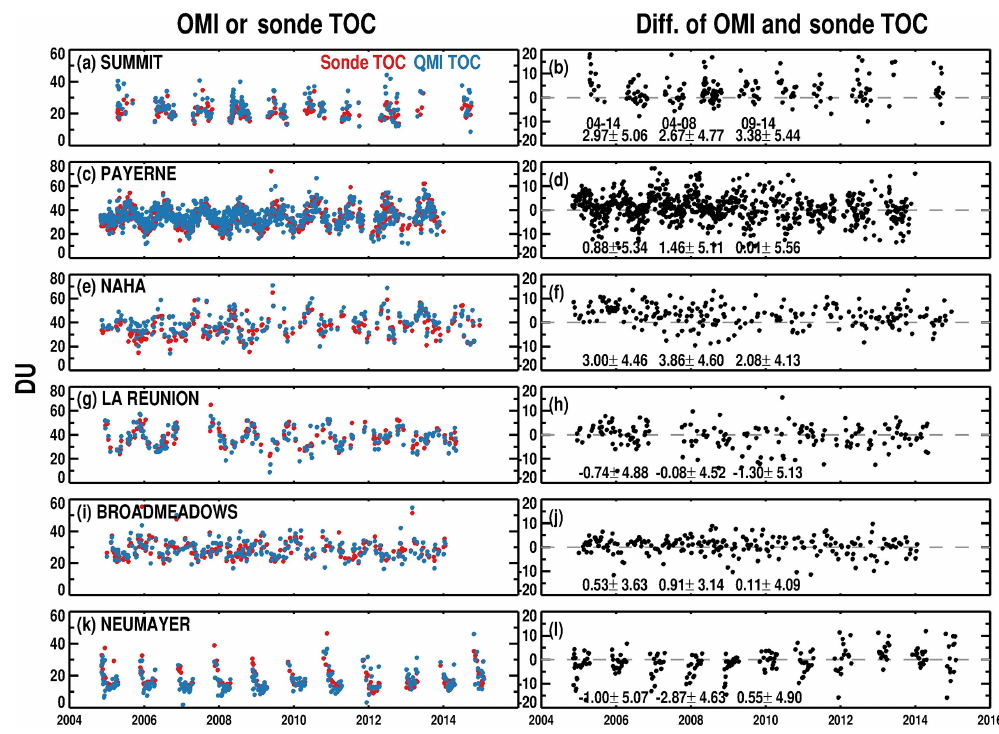
Figure 10. (a, c, e, g, i, k) Time series of OMI tropospheric ozone columns (TOCs) as green dots and ozonesonde TOCs (with OMI AKs applied) in Summit (38.48 ◦ W, 72.57 ◦ N), Payene (6.57 ◦ E, 46.49 ◦ N), Naha (127.69 ◦ E, 26.21 ◦ N), La Réunion (55.48 ◦ E, 21.06 ◦ S), Broadmeadows (144.95 ◦ E, 58.74 ◦ S), and Neumayer (8.27 ◦ W, 70.68 ◦ S), as well as (b, d, f, h, j, l) their corresponding differences, including